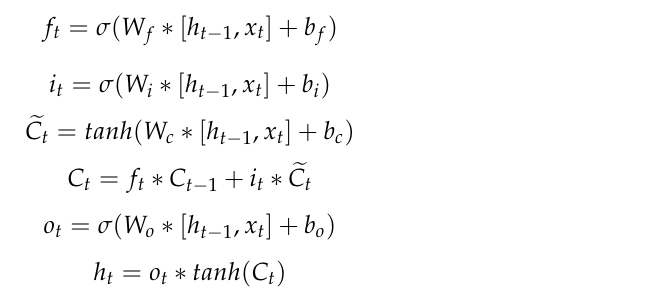
Figure 2. ( a ) Recurrent Neural Network; ( b ) Long Short Term Memory (LSTM) cell. The long-term dependency was improved with the Long Short-Term Memory (LSTM) structure, introduced by Hochreitener and Schmidhurber [42] for the first time in 1997. They replaced the typical recurrent unit of RNNs with a more complex gated recurrent unit. The LSTM used in this study is a standard LSTM, and it is shown in Figure 2b. The LSTM forward propagation process is described